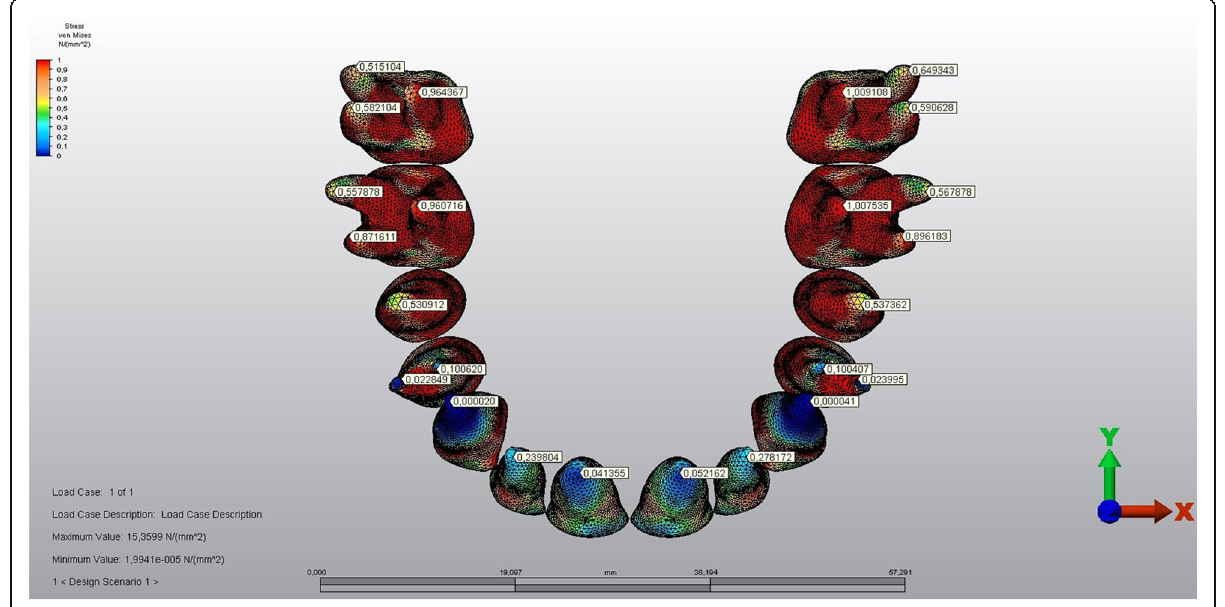
Fig. 10 The stressed areas of the roots